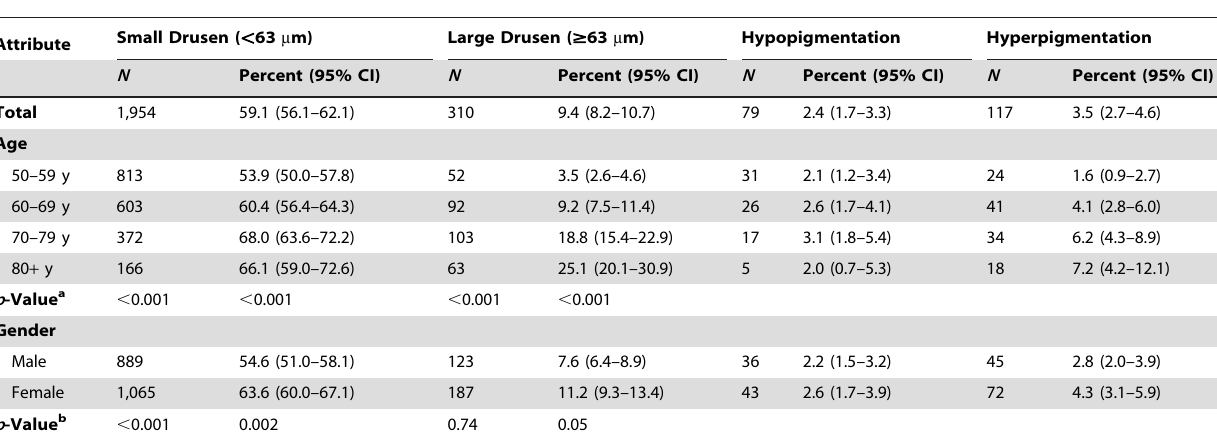
Table 2. Number and prevalence of features of early AMD (image group) and age-related maculopathy by sex and age ( n =3,304).